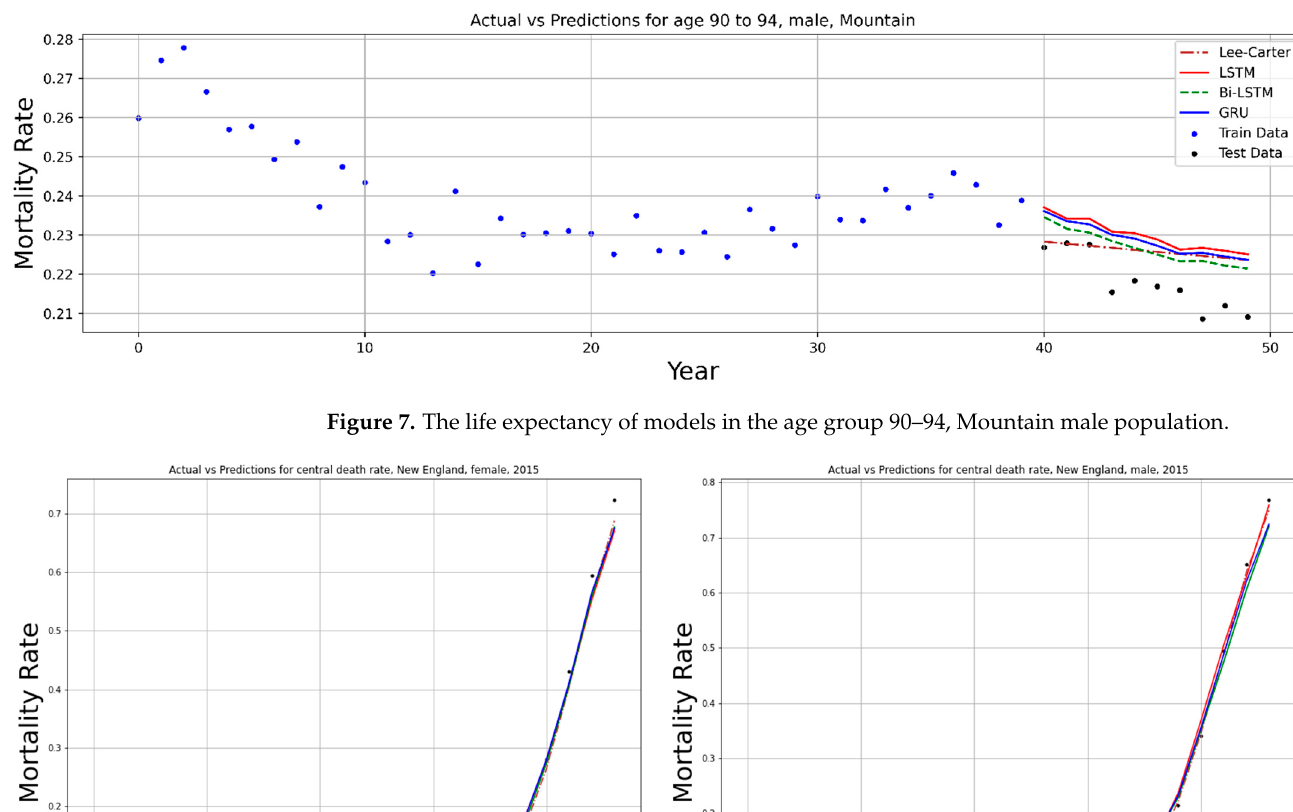
Figure 7. The life expectancy of models in the age group 90–94, Mountain male population.